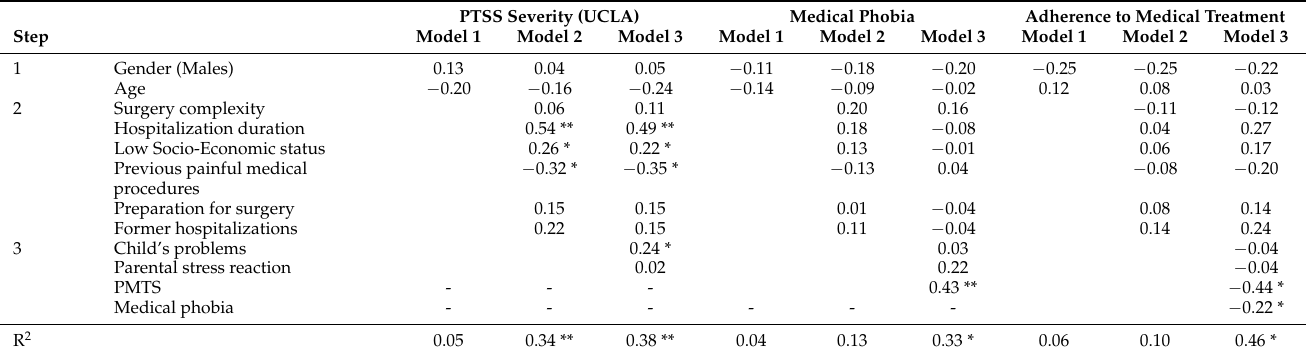
Table 3. Standardized coefficients of linear regression showing correlation of PTSS (UCLA), medical phobia and adherence to medical